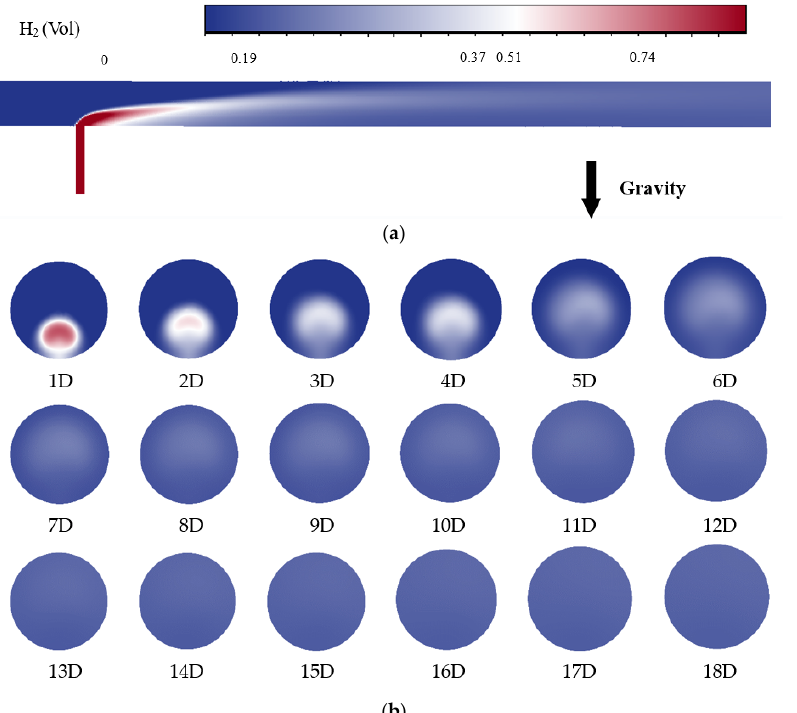
Figure 4. Distribution of hydrogen concentration in natural gas pipeline ( v CH = 2.78 m/s, HBR = 10%, p = 0.3 MPa, T = 300 K, and d / D = 0.2). ( a ) Distribution of hydrogen concentration on YZ slice of natural gas pipeline. ( b ) Distribution of hydrogen concentration on different cross sections of natural gas pipeline. For further analysis, the hydrogen concentration at the top, bottom, and middle of the natural gas pipeline and the change of the COV along with the flow distance (different pipeline cross sections) are demonstrated in Figure 5. As the flow distance increases, the hydrogen concentration at the top of the natural gas pipeline increases and the hydrogen concentration at the bottom of the natural gas pipeline decreases, and at the middle of natural gas pipeline, it increases first and then decreases. The reason for this interesting phenomenon can be attributed to the fact that under the effect of buoyancy force, hydro- gen gas flows to the top of the natural gas pipeline. Figure 5 also illustrates that the COV of the hydrogen concentration is smaller than 0.05 when z / D > 21 (21st pipeline cross sec- tion), which indicates that the hydrogen and methane have been mixed uniformly.